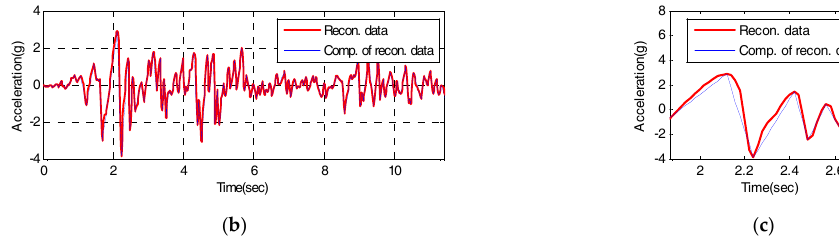
Figure 17. Time domain of compressive signal using peak-picking values: ( a ) Time from 0 to 50 s; ( b ) Detail 1; ( c ) Detail 2.